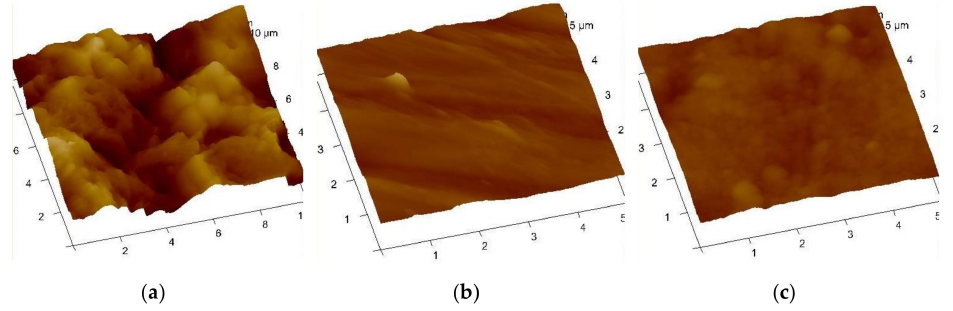
Figure 14. Atomic force microscope (AFM) roughness micrographs of ( a ) blank, ( b ) una ff ected, and ( c ) 600 ppm PBSLP